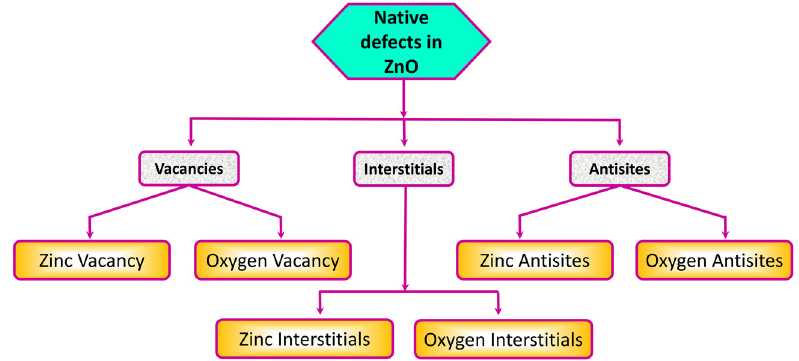
Figure 10: Di ff erent types of defects found in ZnO.